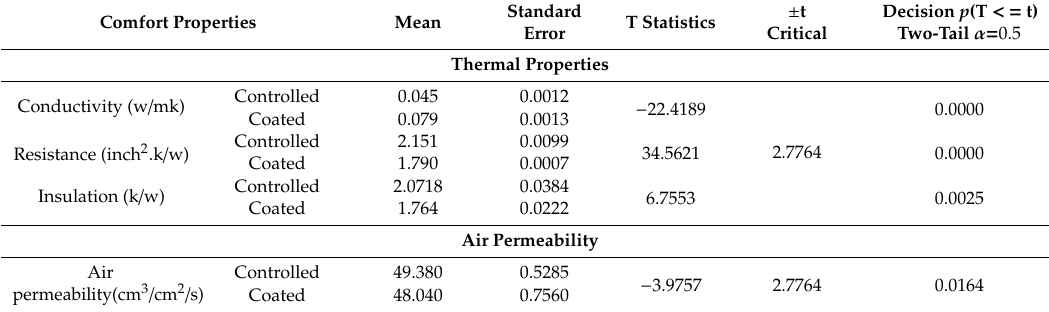
Table 9. E ff ect of coating on thermal conductivity and air